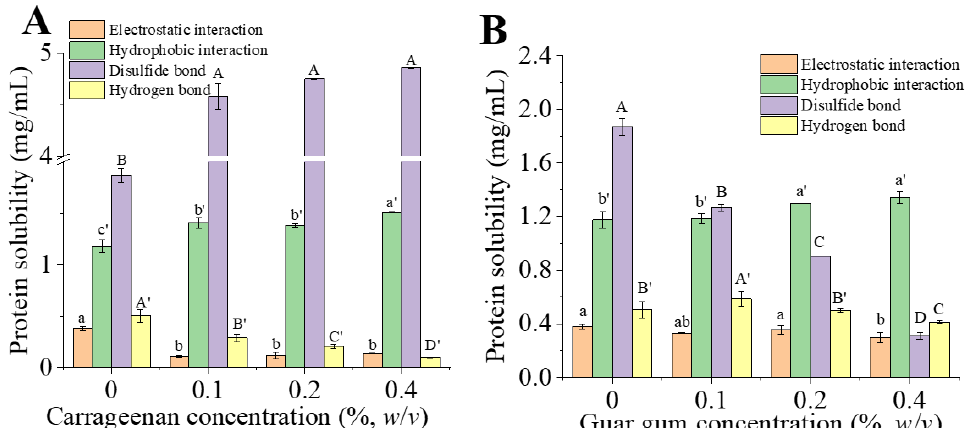
Figure 4. The molecular forces of PC-CG gel ( A ) and PC-GG gel ( B ) at different concentrations of CG/GG. The protein solubility of gels represented the corresponding molecular force. The phycocyanin gel without any polysaccharide was used as a control. Each value represents the mean ± standard deviation ( n = 3). The values of different letters in the same column were significantly different ( p < 0.05).